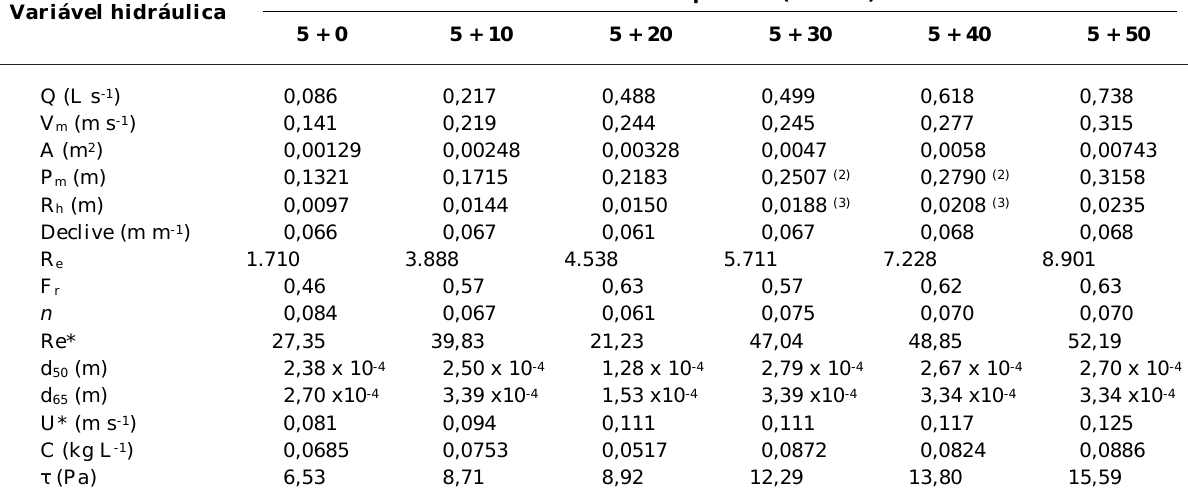
), m ), velocidade d65